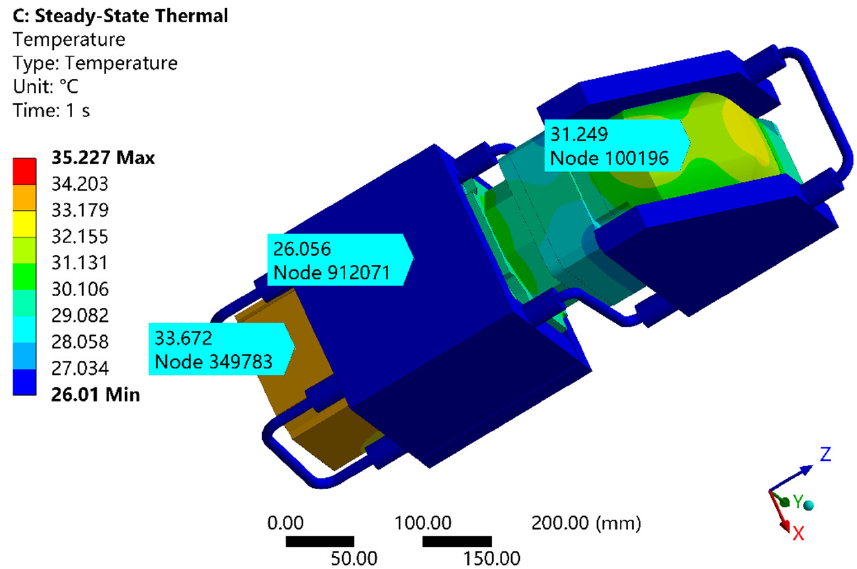
Figure 12. Simulation results of working condition 2.